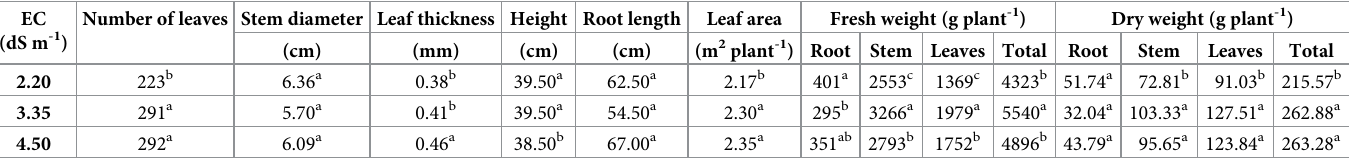
Different letters indicate significant difference at p � 0.05 according Tukey´s